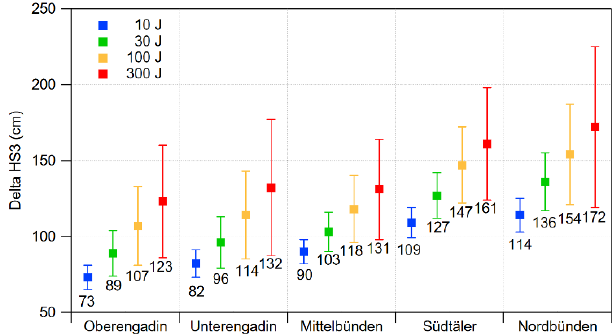
Figure 3. (cid:49) HS3 values in centimeters and associated uncertainties for the five different climatic regions of Grisons and the four sce- narios normalized to an elevation of